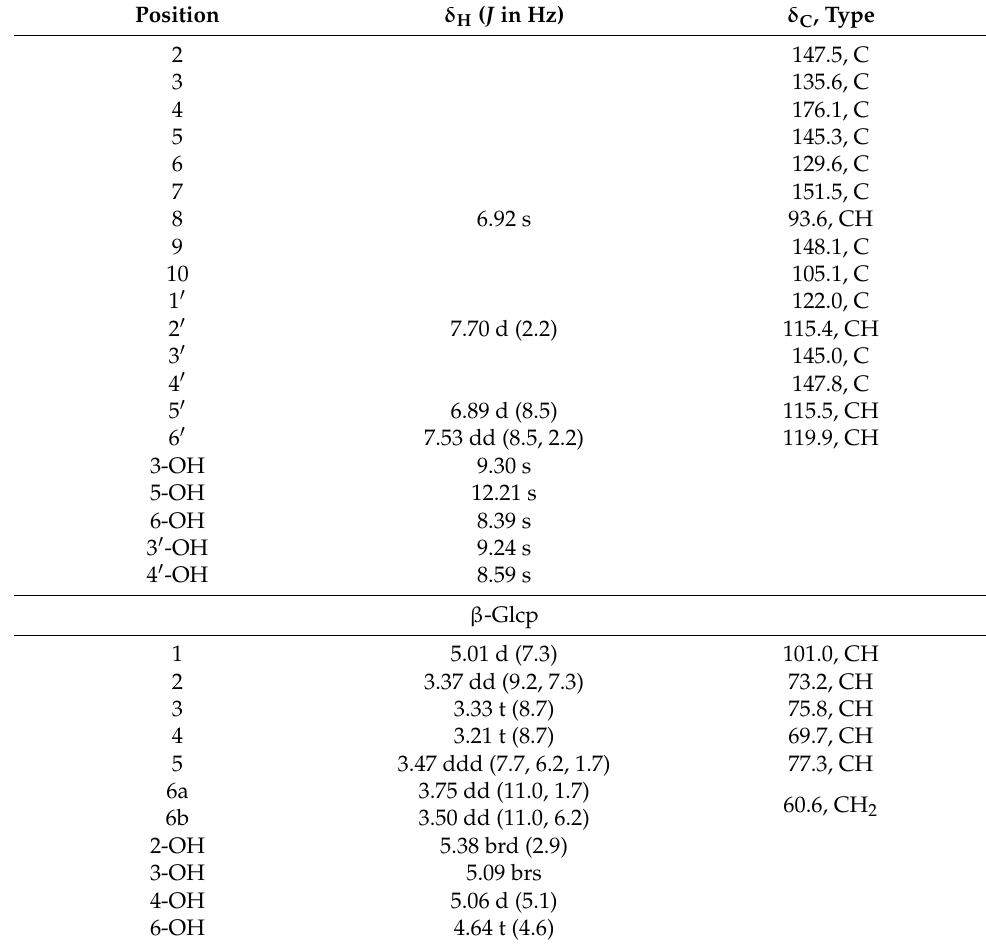
Table 2. 1 H- and 13 C-NMR data of quercetagitrin (compound 34 ; 500 and 125 MHz, DMSO- d 6 , 30 ◦ C).